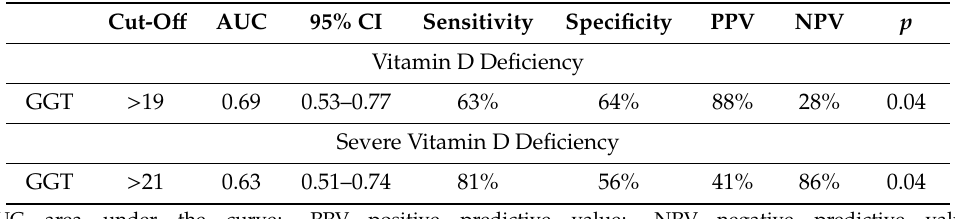
Table 4. Receiver operating characteristics curves identifying the discrimination thresholds of gamma glutamyltransferase for vitamin D deficiency and severe vitamin D deficiency.